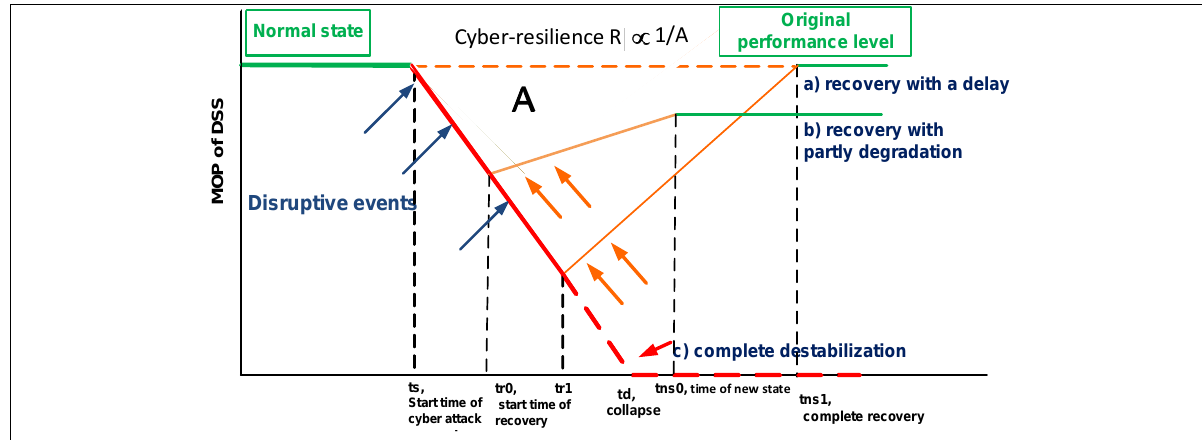
Fig. 2. DSS resilience: a) recovery with a delay [13]; b) recovery with degradation [14]; c) complete